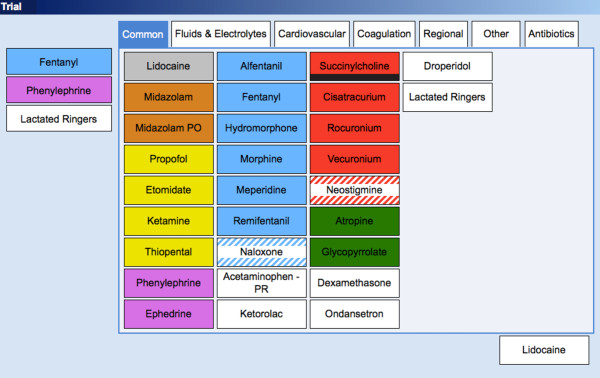
Screen shot of categorical display format. The drug entry screen was constructed with “tabs” across the top for Common Drugs, Fluids and Electrolytes, Cardiovascular, Coagulation, Regional Anesthetic, Antibiotics and Other Drugs. Under each category, drugs were grouped by category.